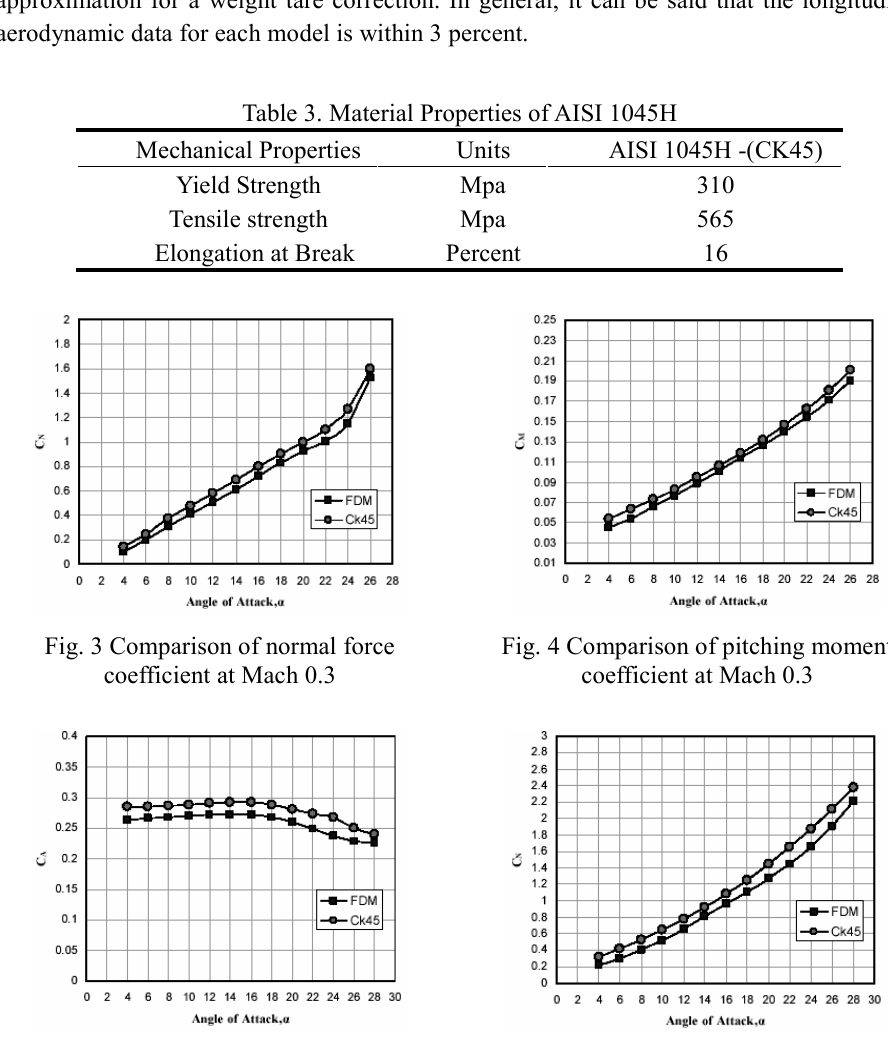
Fig. 6 Comparison of normal force coefficient at Mach